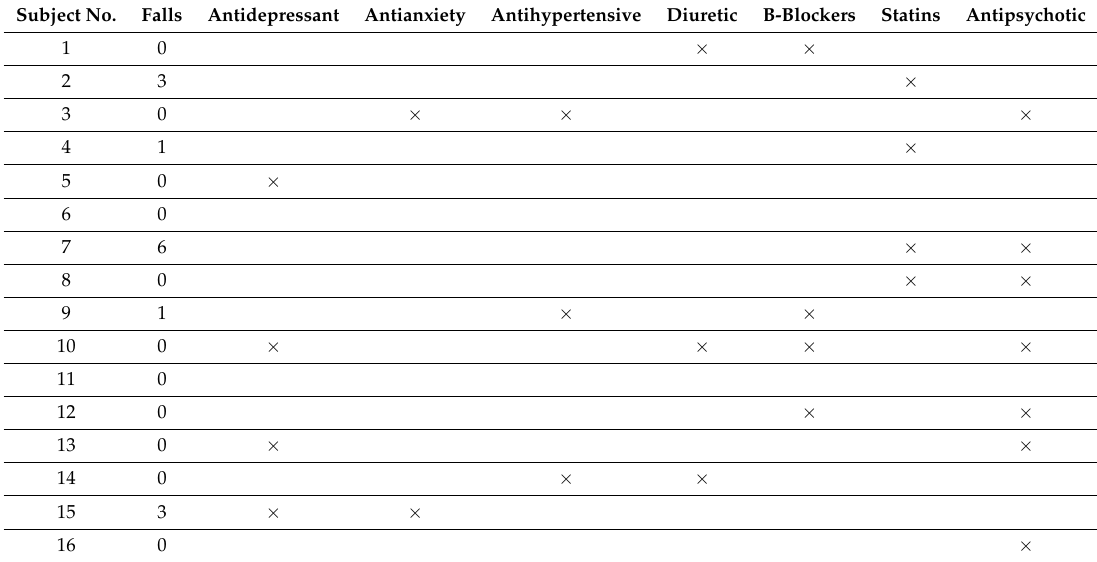
Table 1. List of prescribed medications for all participants.